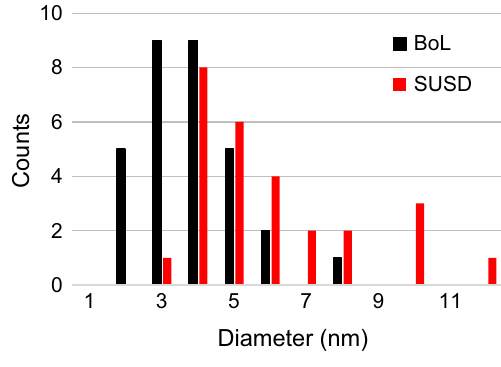
Fig. 9 Relative particle size distribution of Pt particles at beginning of life (BoL) and after SU/SD cycling